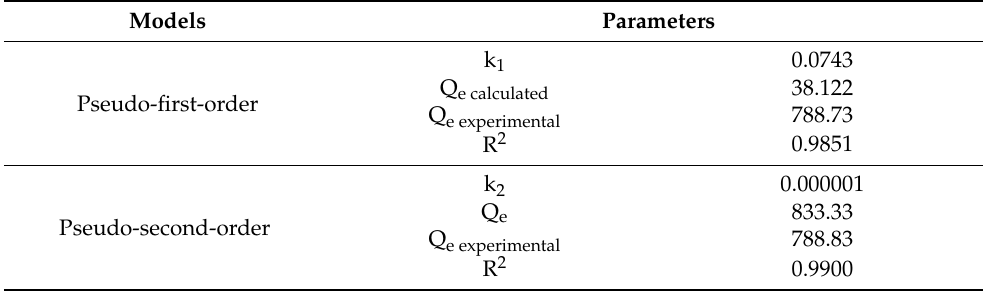
Figure 8. ( A ) Pseudo-first-order and ( B ) pseudo-second-order models (Contact time (5–30 min), pH 7, biosorbent dosage = 0.005 g, amoxicillin concentration = 400 mg/L, T = 298 K)). Table 4. Kinetic parameters, for amoxicillin adsorption on the CMT- g -PANI@Fe 2 O 3 .